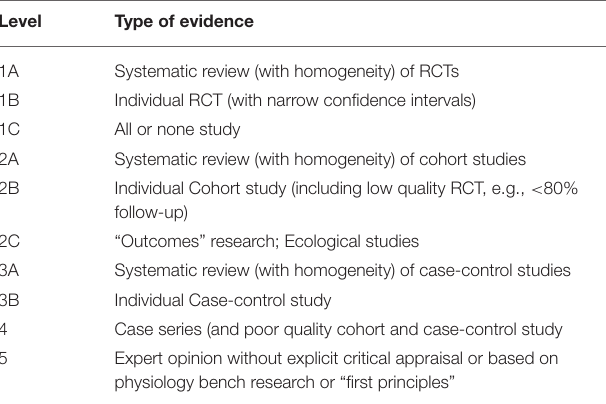
TABLE 3 | Levels of Evidence for therapeutic studies from the Centre for Evidence-Based Medicine (3) in Burns et al. (4).